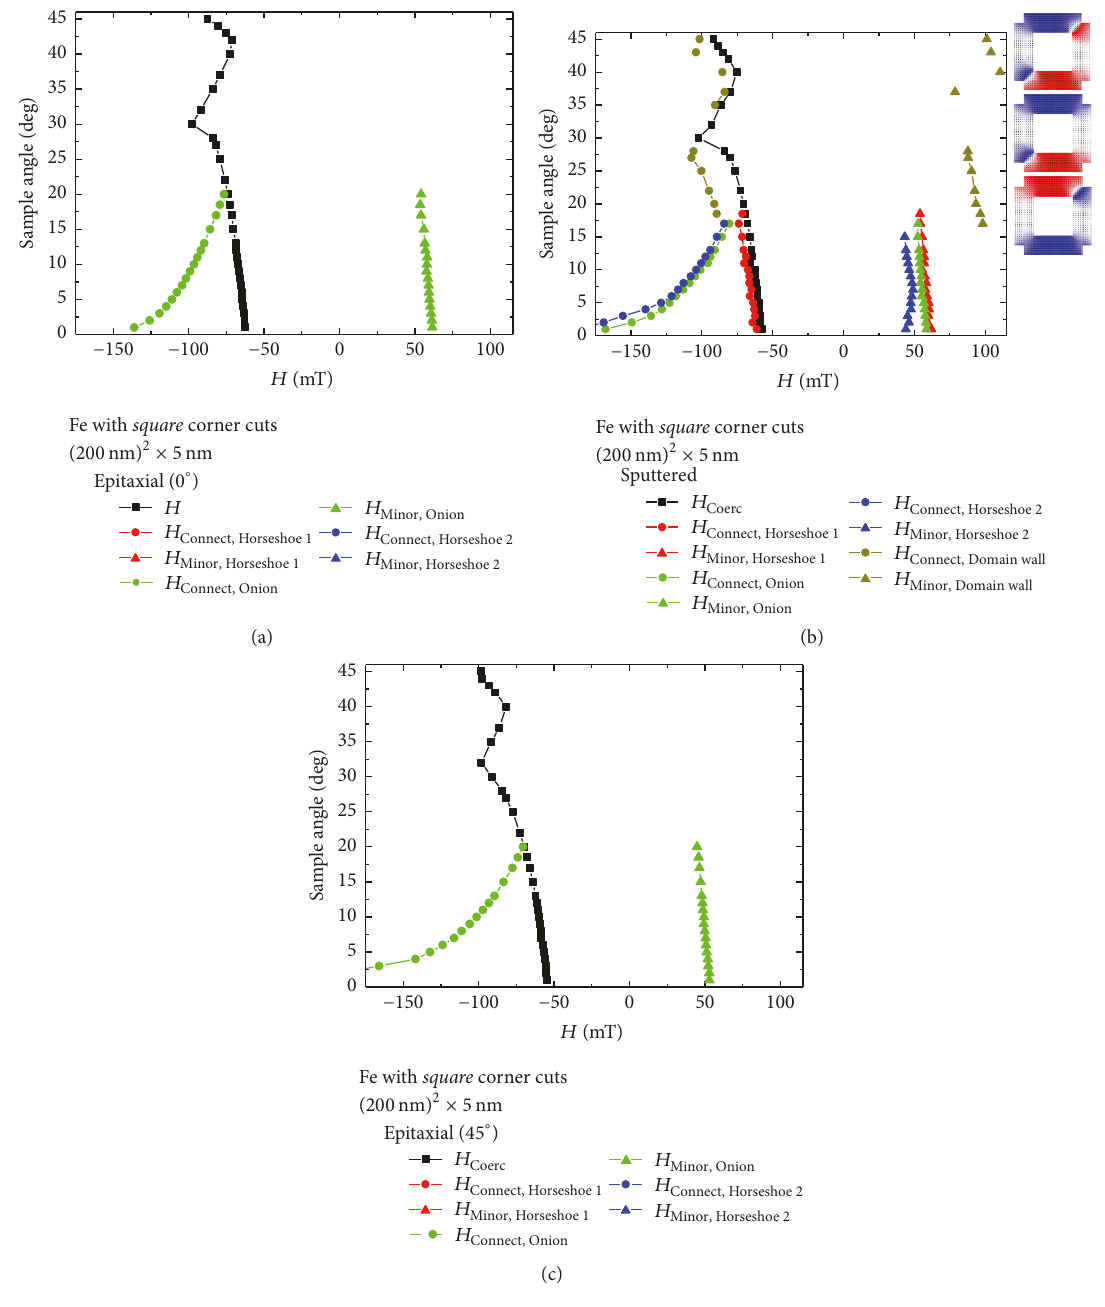
Figure 6: Phase diagrams simulated for nanorings with square corner cuts, assuming epitaxial anisotropy orientation along 0 ∘ (a), 45 ∘ (c), and random anisotropy axes (b). The colors of the texts correspond to those in Figure